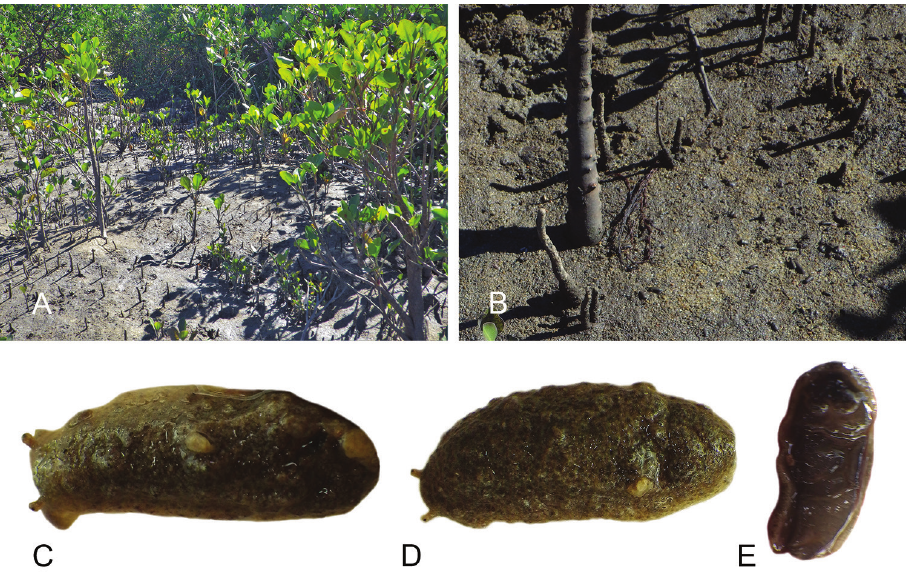
Figure 50. Habitats and live specimens, Wallaconchis achleitneri , Australia, Queensland, Bowen, Doughty Creek. A–B Type locality, sandy area with Avicennia and Rhizophora trees in narrow band by the creek (st 117) C–D Dorsal view, approximately 14 mm long (MTQ st117) E Ventral view, approximately 14 mm long (MTQ st